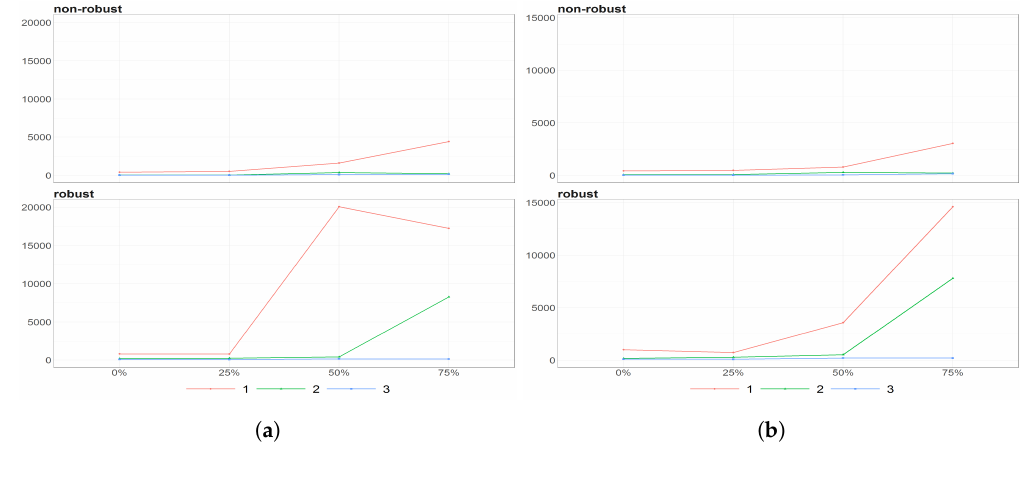
Figure 24. The eigenvalues obtained using PPCA for female ( a ) and male ( b ) population of Death Rates for different percentages of maximal missing entries in rows (x axis). Colours of lines corresponds to different eigenvalues, first (light brown), second (dark blue) and third (dark brown) highest. Every subfigure is divided into two subplots corresponding to robust estimation of standard divinations (upper plot) and sample one (bottom plot).